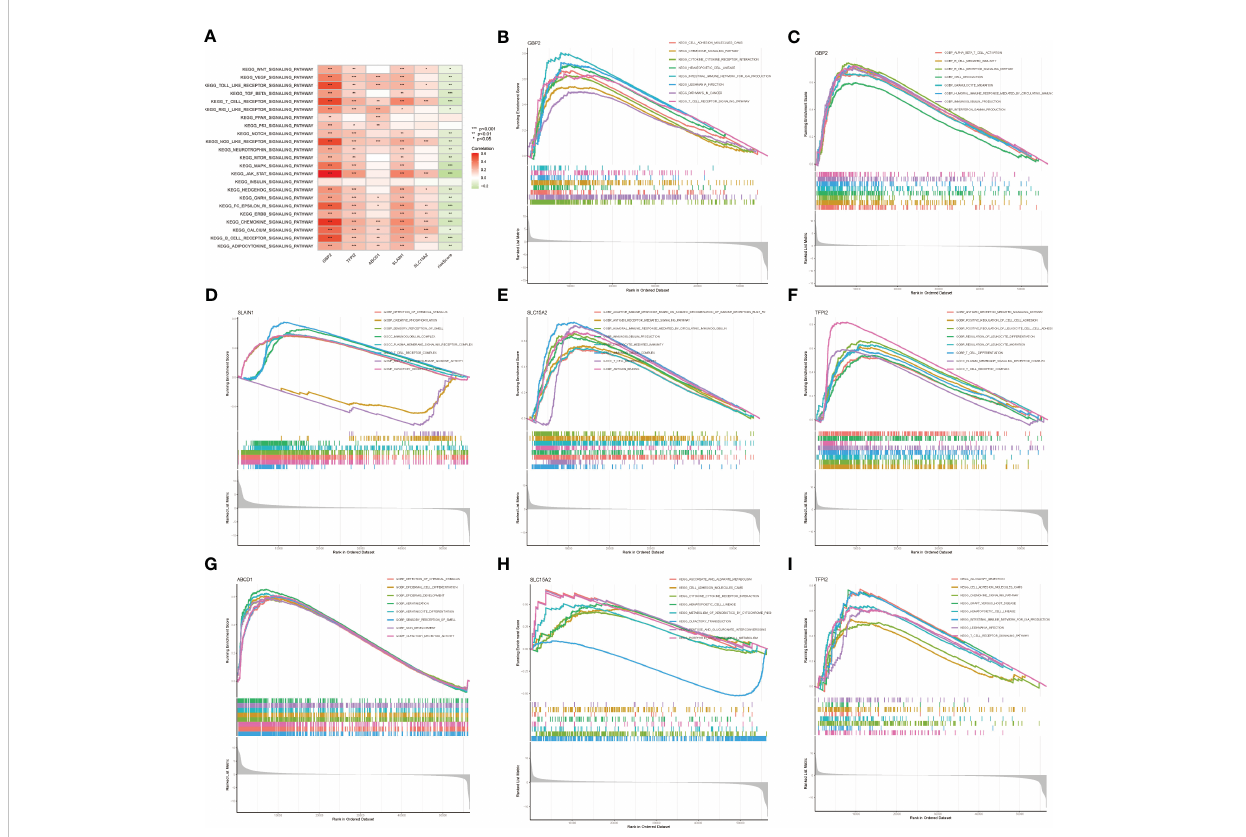
FIGURE 9 GSVA and GSEA enrichment analysis based on LNPRS in the TCGA cohort. (A) KEGG signaling pathways of genes that independently in fl uence prognosis and LNPRS. (B – I) KEGG and GO enrichment analysis of fi ve genes based on